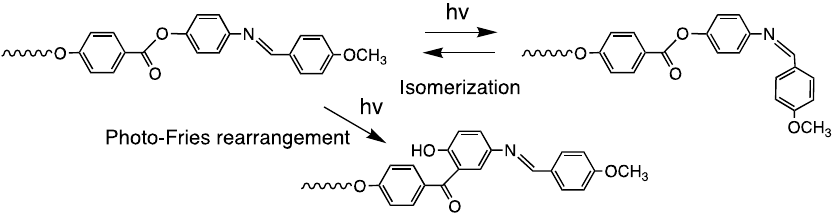
Scheme 1. Photoreaction of P4 using linearly polarized 313 nm light.